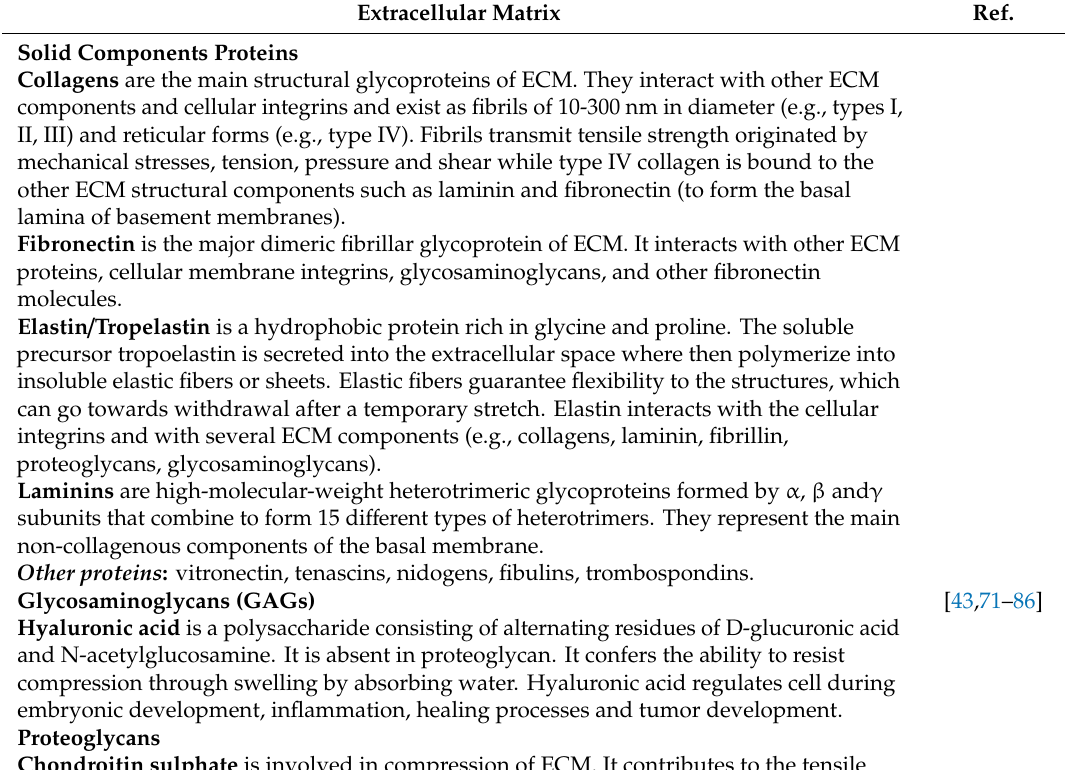
Table 2. Macromolecular complexes for mechanotransduction activity. Extracellular